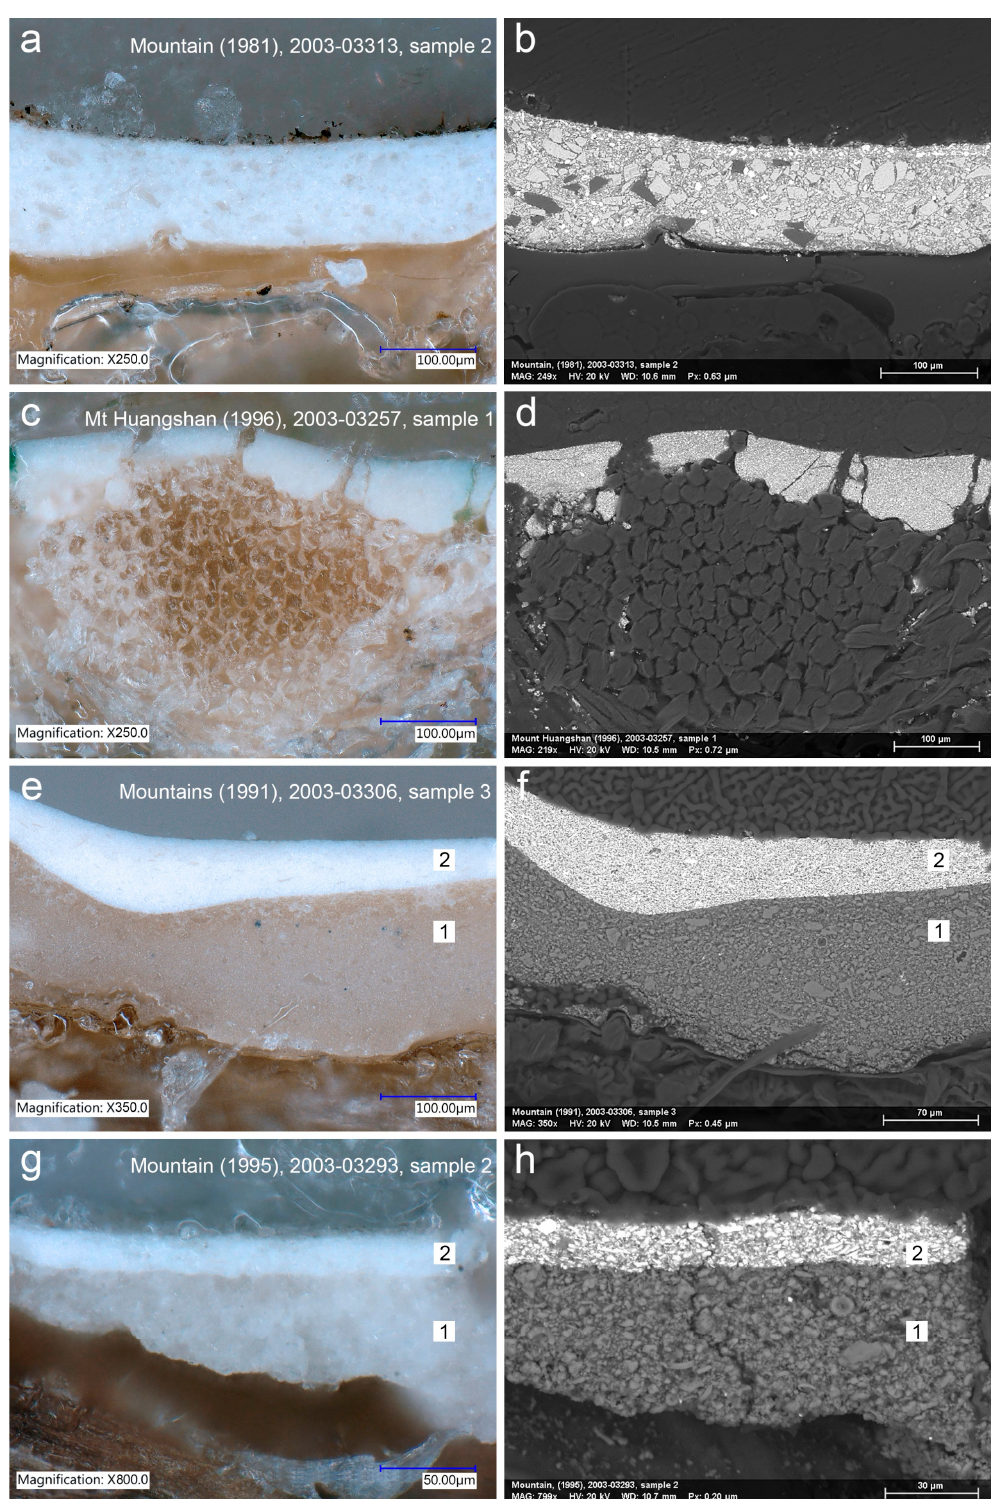
Figure 7. Optical microscopy and corresponding backscattered electron (BSE) images of cross-sections representing two types of identified grounds: ( a – d ) single-layered ground of type 1 with coarsely ( b ) and finely ( d ) ground barium white compound particles; ( e , g ) double-layered ground of type 2 characterised by a high concentration of chalk in the bottom layer (dark grey) and predominant presence of lead white in the top layer (white) ( f , h ). Numbers differentiate between layers of the